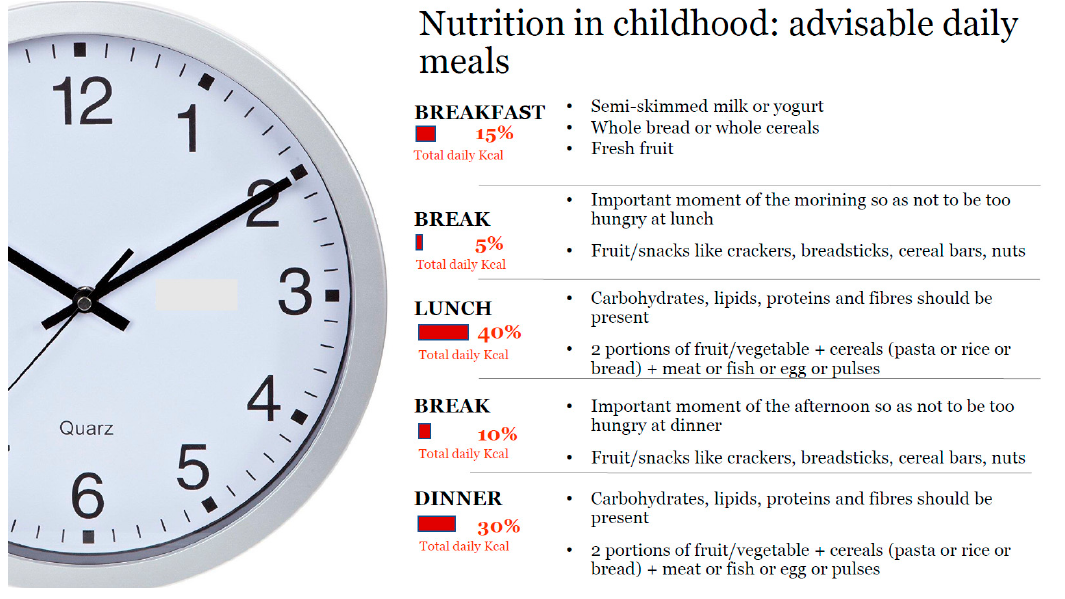
Figure 2. Advisable daily meal distributions in childhood, modified from Giovannini et al. [57]. Table 2. Recommended macronutrients intake for school-age children, modified from SINU [55].